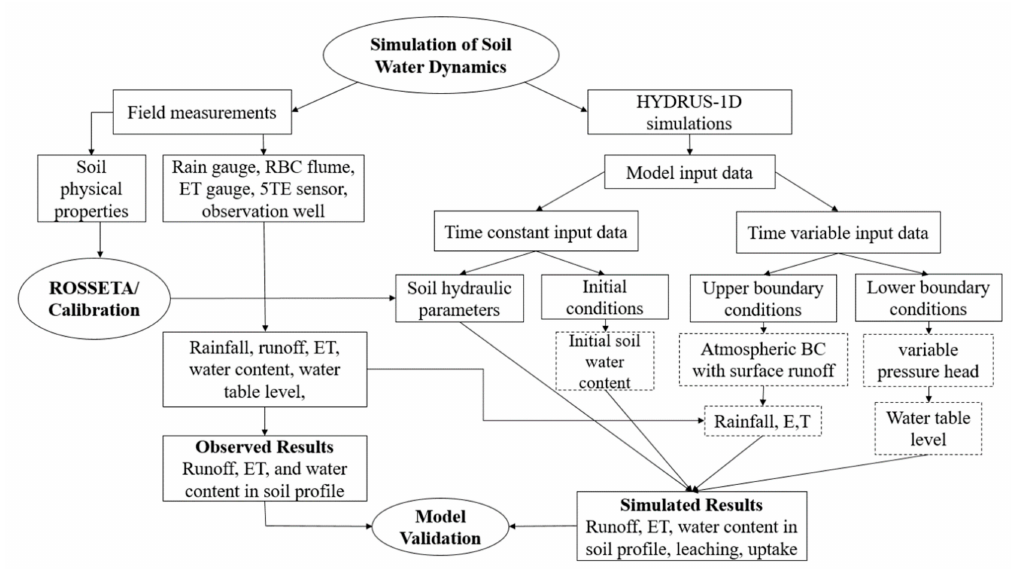
Figure 4. Flow chart presenting model simulation process and calculation of water balance